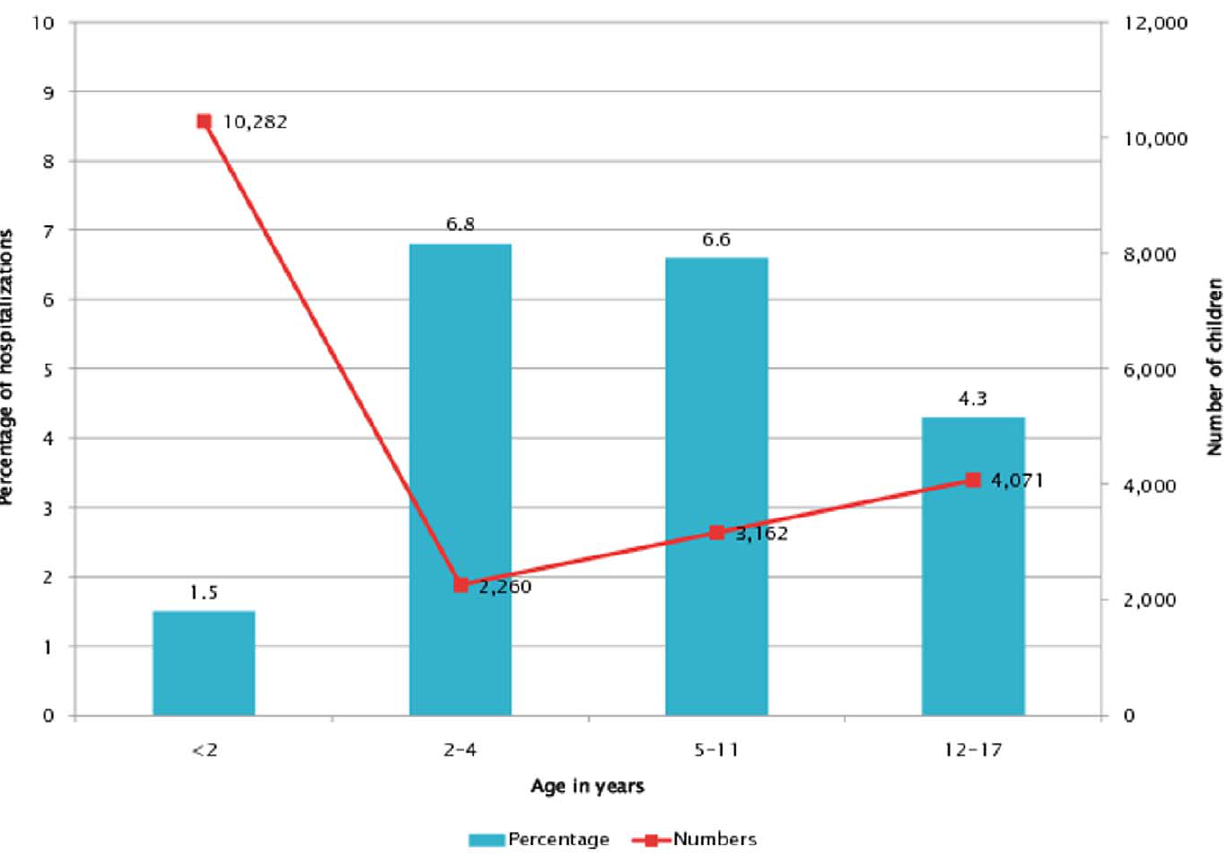
Figure 1. Vancomycin use by age group.